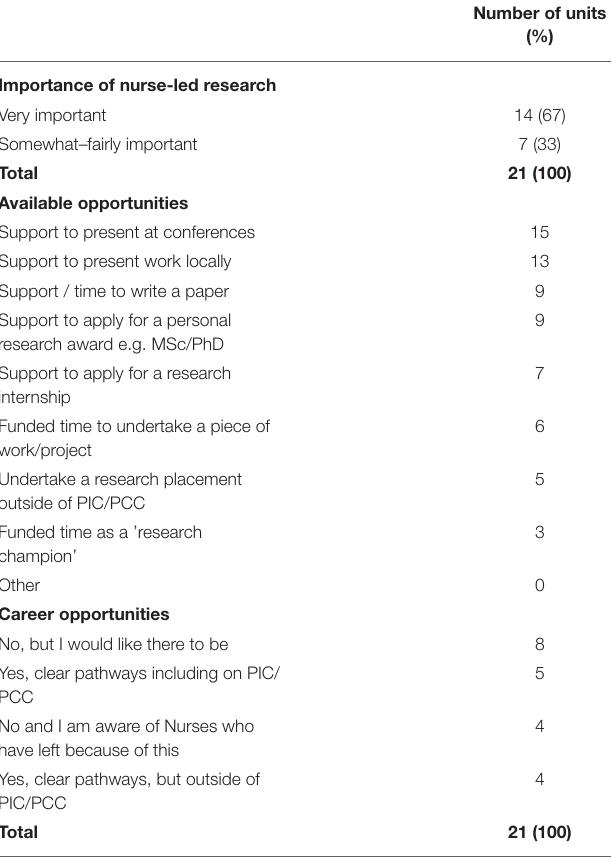
TABLE 4 | Clinical academic